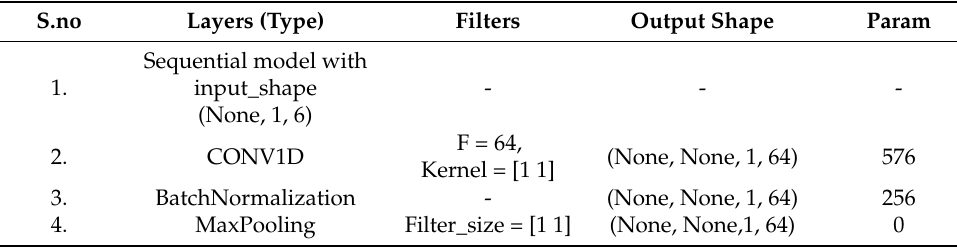
Table 6. Layered structure of